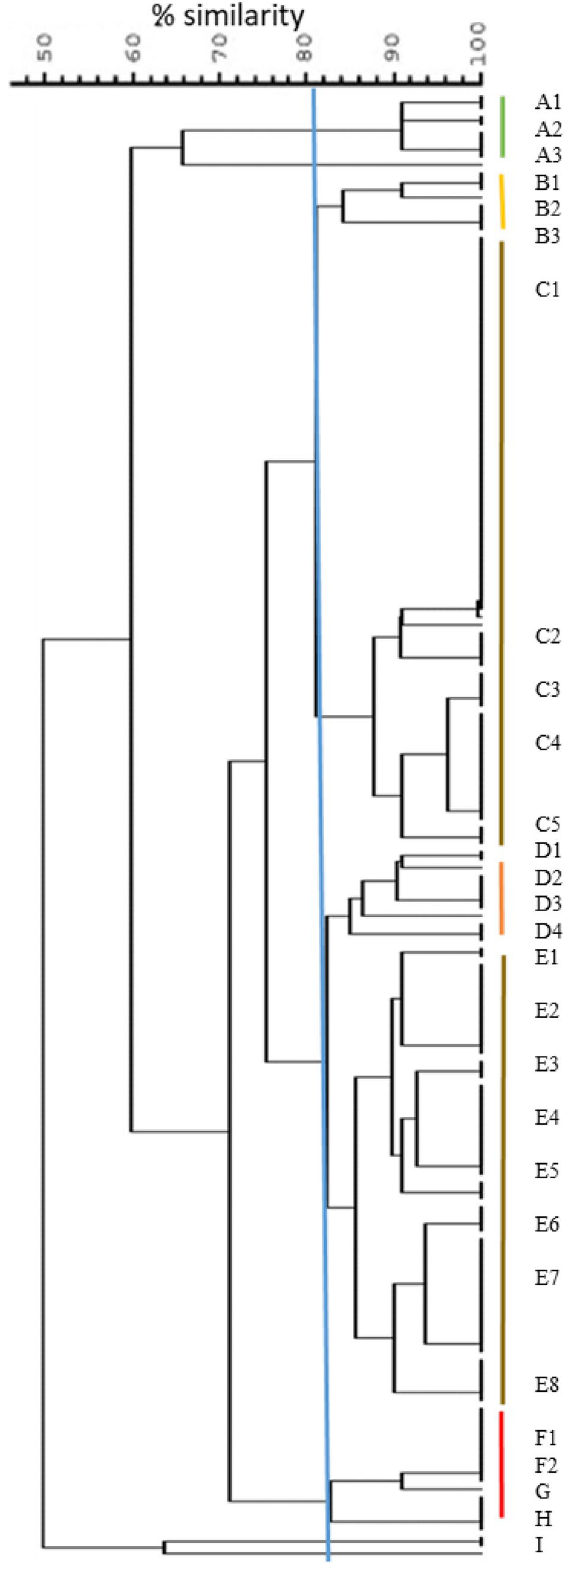
Figure 4. PFGE dendrogram. The tree was generated from composite fingerprinting with 80% similarity between the isolates. The pulsotypes are designated by the letters A through F, and individual patterns within these groups are